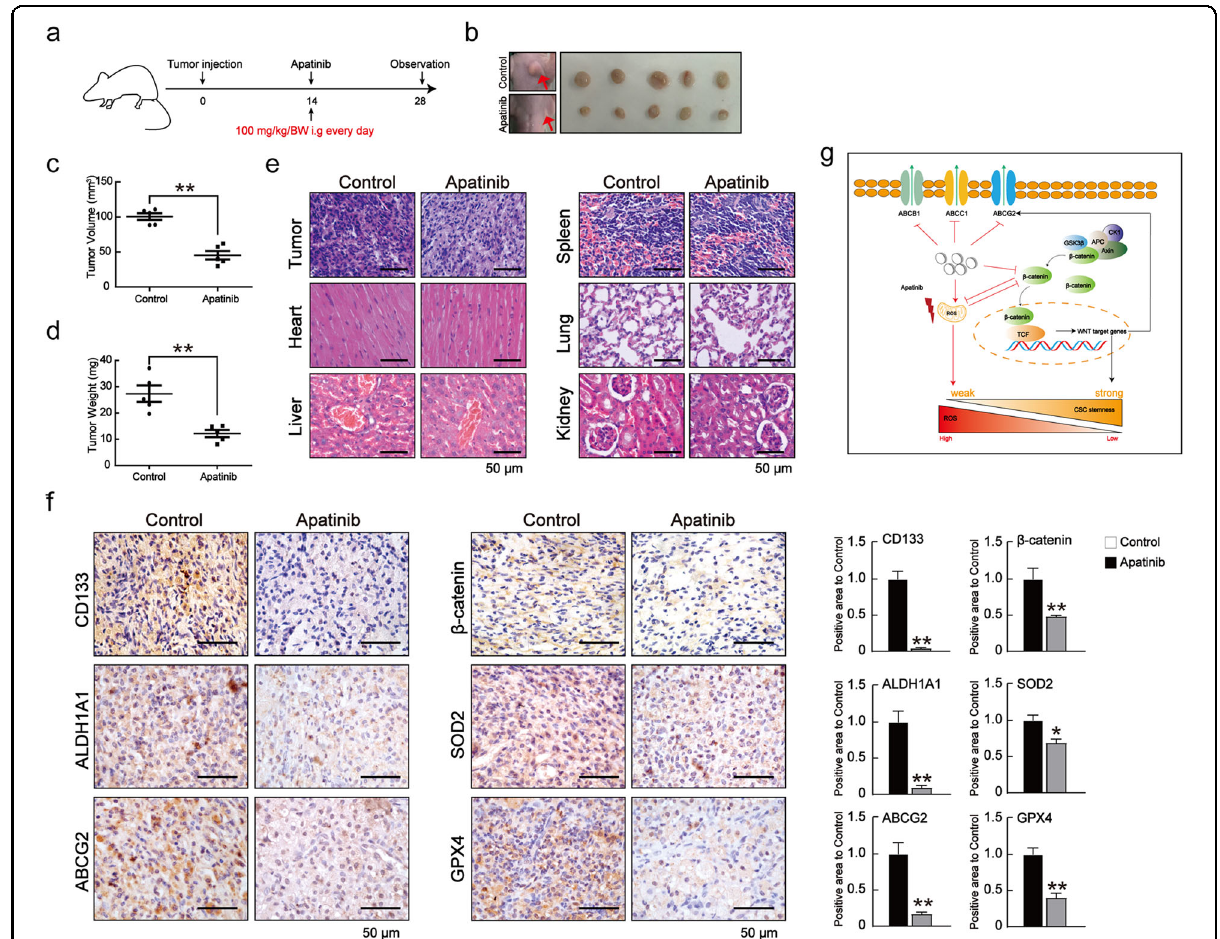
Fig. 8 Apatinib inhibited tumor growth in vivo. a Male BALB/c nude mice (5 weeks of age) were injected with 5 × 10 6 A549 cells. After 14 days, apatinib (100 mg/kg body weight) was orally administrated daily for another 14 days. b Subcutaneous tumors in mice on the 28th day after the injection of A549 cells. c – d Tumor volumes and masses were determined on the 28th day after injection. Unpaired t -test was used. Data are presented as mean ± SD ( n = 5). ** p < 0.01 compared to the control group. e H&E staining of tumor, heart, liver, spleen, lung and kidney. Scale bar